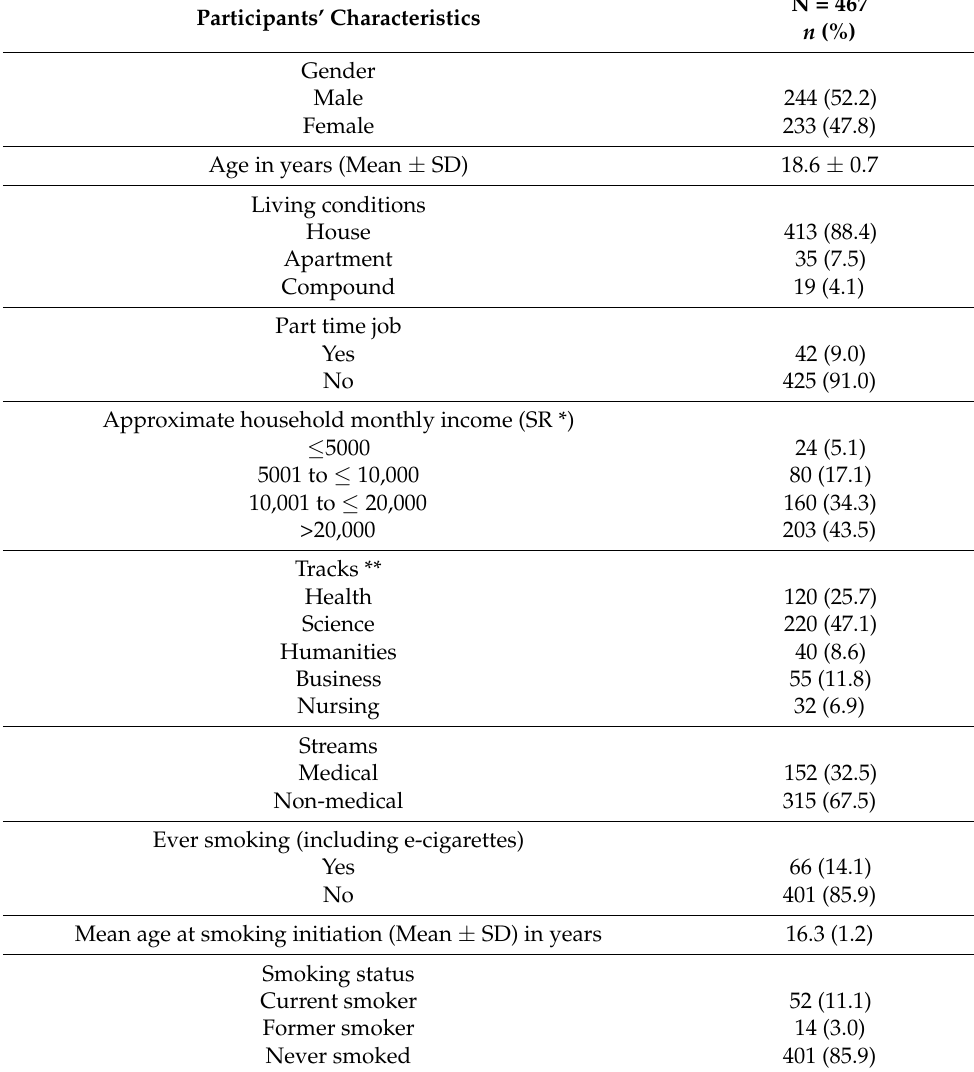
Table 1. Participants’ socio-demographic characteristics and smoking